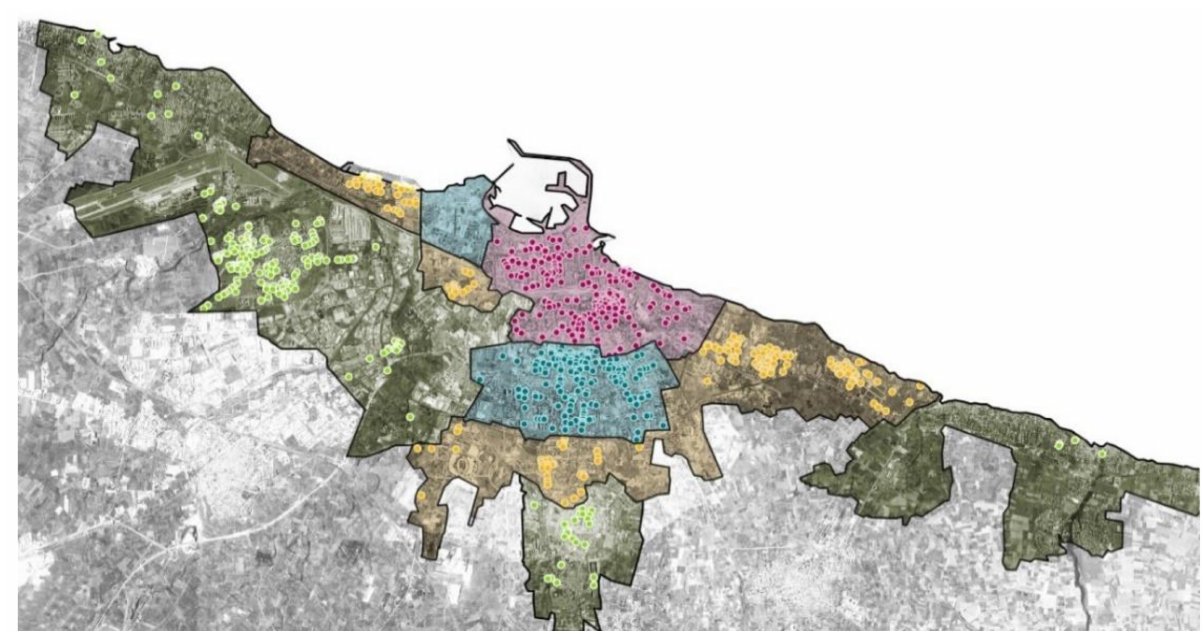
Figure 5. Localization of the study sample properties in the city of